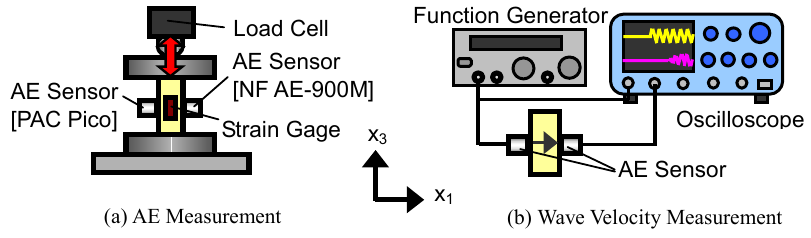
Fig. 3. Schematic diagram of cyclic compression test